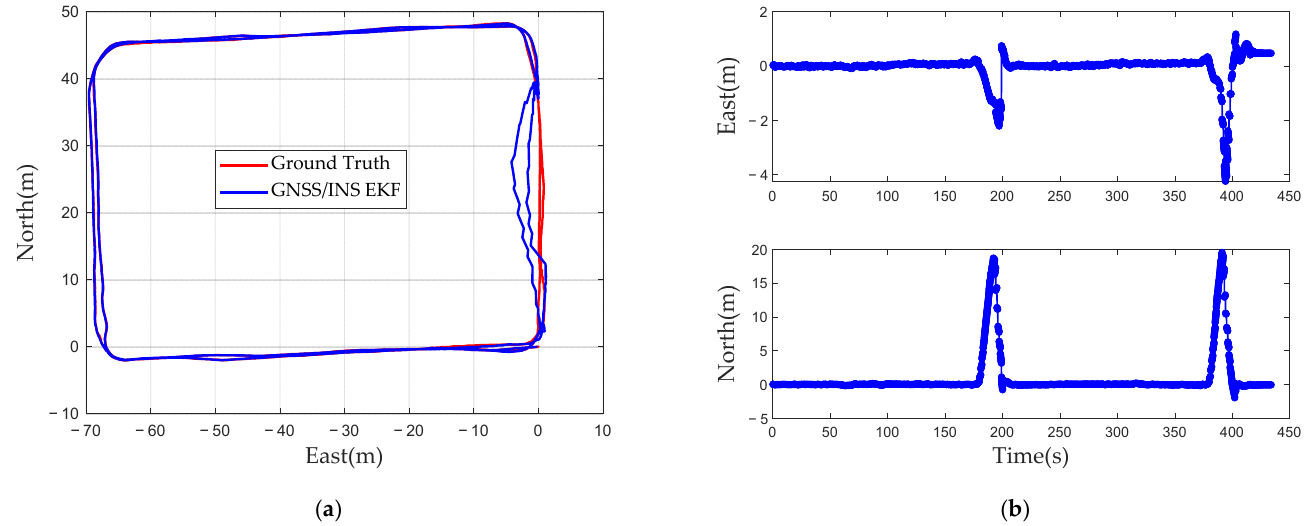
Figure 16. Trajectory and positioning errors in the east and north. ( a ) The trajectory of the vehicle in case 2. ( b ) The positioning errors in the east and north.